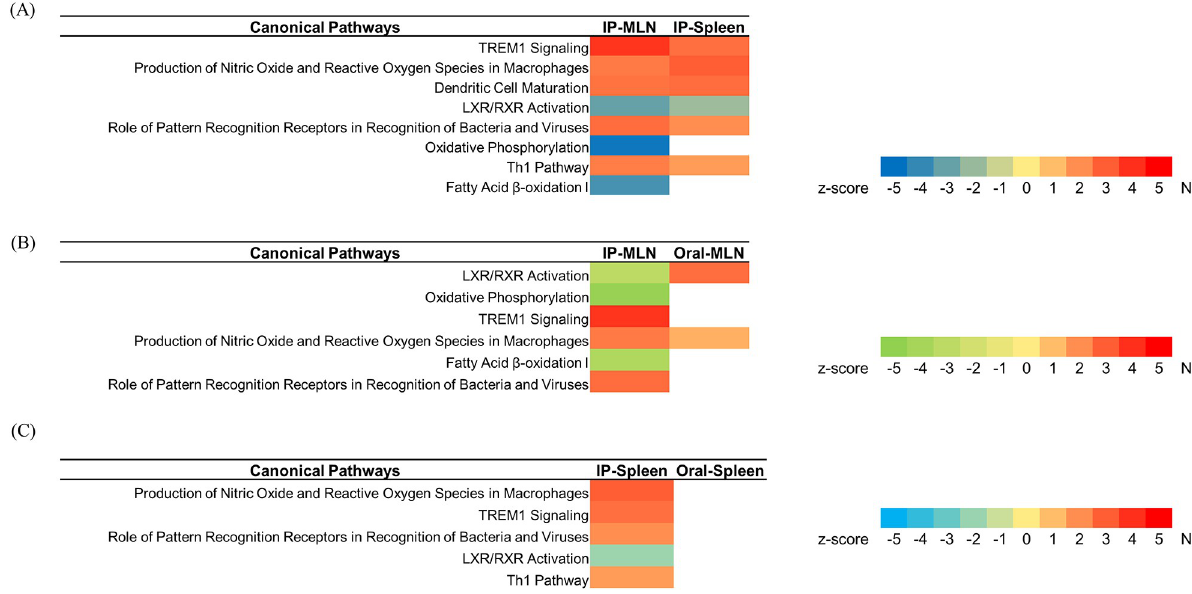
Fig 5. Canonical pathway analysis of DEGs related to immune response and lipid metabolism from each group using the IPA tool. Canonical pathways sorted by z score within the top 50 canonical pathways from the (A) IP route (MLN vs. spleen), (B) MLN (IP route vs. oral route), and (C) spleen (IP route vs. oral route). Genes that were not significant ( p value � 0.05 or Log 2 FC < 1.0) are shown as N/A.